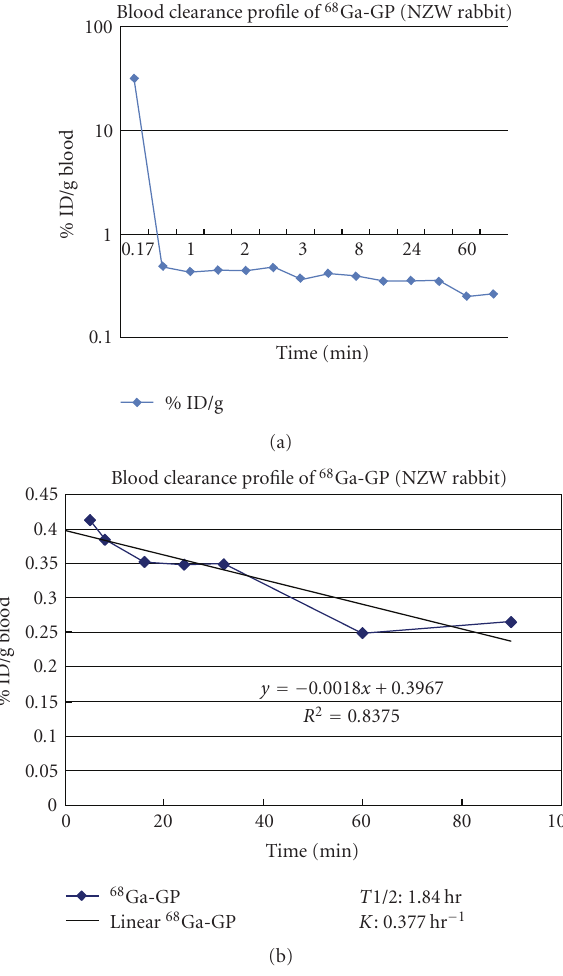
Figure 10: Blood clearance (a) and half-life analysis (one compart- ment) of 68 Ga showed the half-life of 68 Ga-GP was 1.84hr with K value of